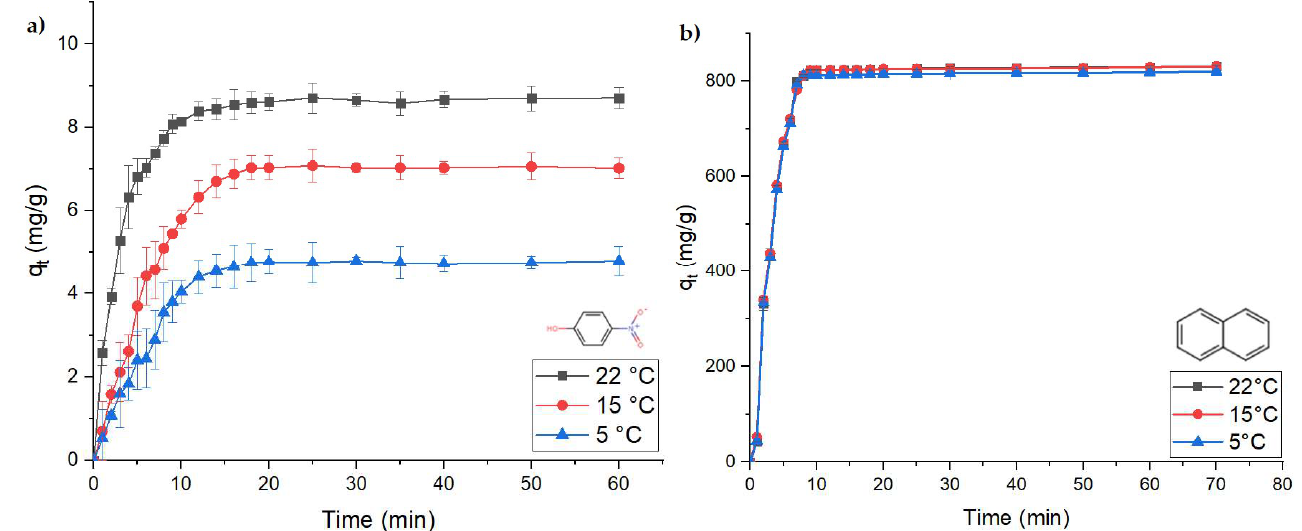
Figure 4. Kinetics for the adsorption of model pollutants at variable temperatures (5, 15, and 22 °C): ( a ) PNP and ( b ) naphthalene. The solid line represents a visual guide to illustrate the trend of the kinetic profile.